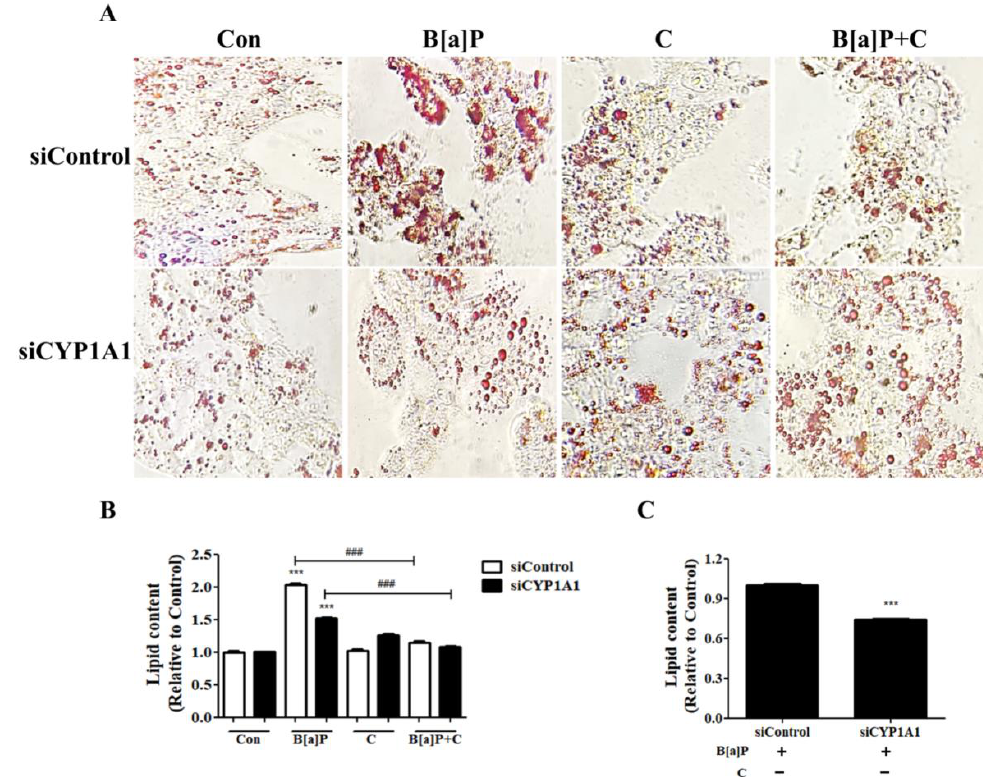
Figure 6. Effect of Cyp1a1 knockdown on B[a]P-induced lipid accumulation. ( A ) Modulatory effect of decreased expression of CYP1A1 on the accumulation of lipid droplets induced by B[a]P treatment in HepG2 cells. ( B ) Quantitation of the lipid content of HepG2 cells transfected with the vehicle control and Cyp1a1 siRNA stained with oil red O (ORO). All data were quantified relative to Con in the vehicle control group. ( C ) Suppression of the B[a]P-induced lipid accumulation by Cyp1a1 knockdown in HepG2 cells. N = 3 trials per sample and control. *** p < 0.001, compared with the control; ### p < 0.001, compared with the B[a]P-treated group. Con: control; B[a]P: benzo[a]pyrene (10 µM); C: curcumin (10 µM).